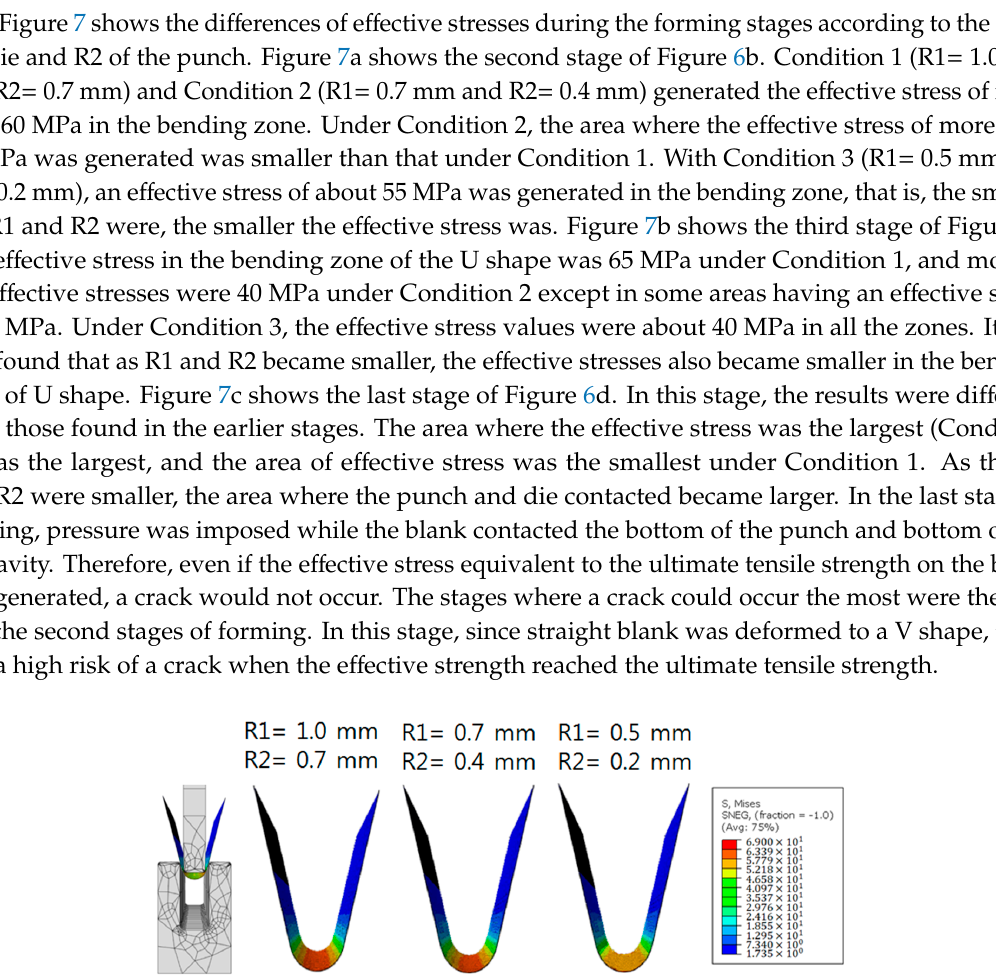
Figure 6. The simulation results in terms of effective stress distribution for the single fin forming by stamping process: ( a ) first stage—V shape deformation; ( b ) second stage—V angle of the blank became narrower; ( c ) third stage—U shape deformation; and ( d ) last stage—fin shape deformation.